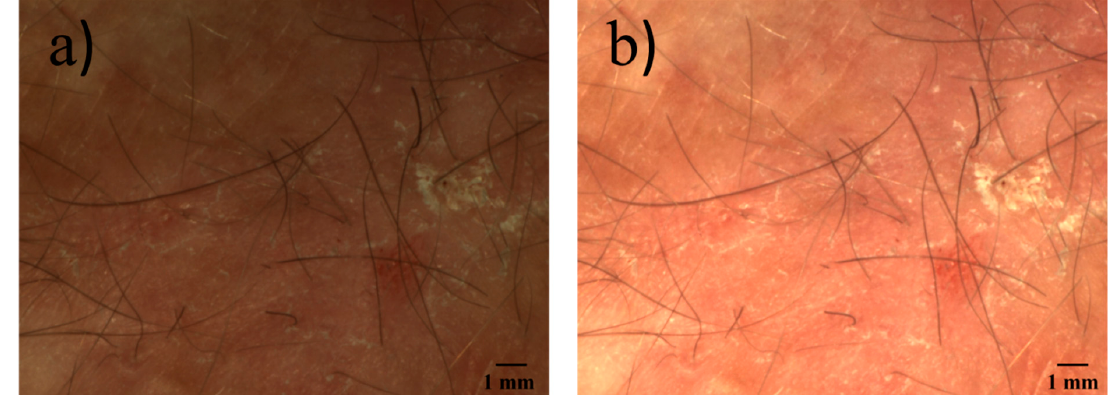
Figure 8. Two images of a patient suffering from Lichen simplex chronicus. ( a ) Uncalibrated image data. ( b ) Same image after color calibration. The image looks brighter and the skin color is more natural and closer to what the doctor is used to see with his bare eyes.